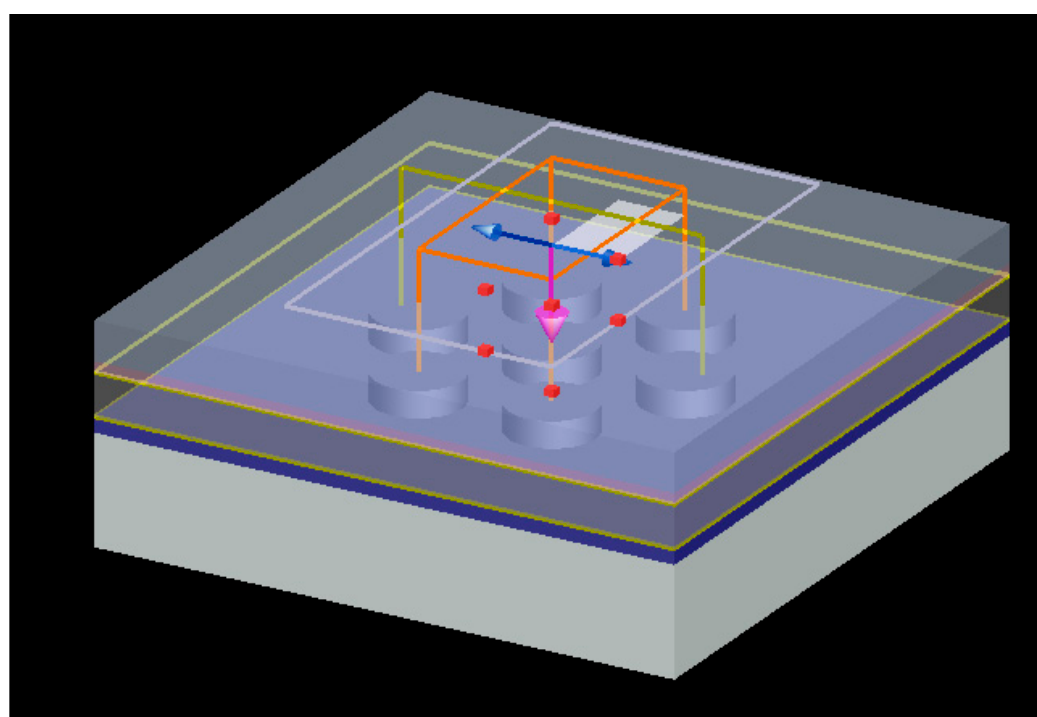
Figure 4. PSC structure designed with nanoparticles.